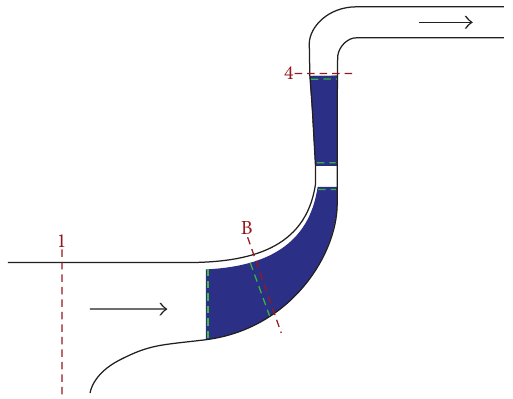
Figure 2: Meridional view of the calculation